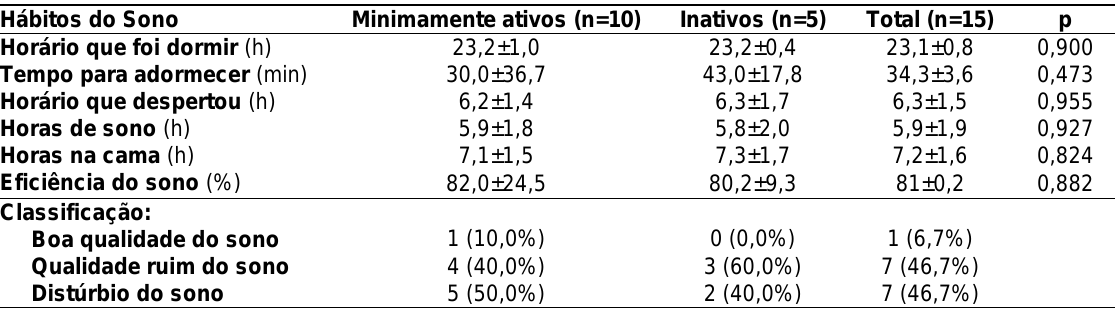
Tabela 2. Parâmetros da Qualidade do